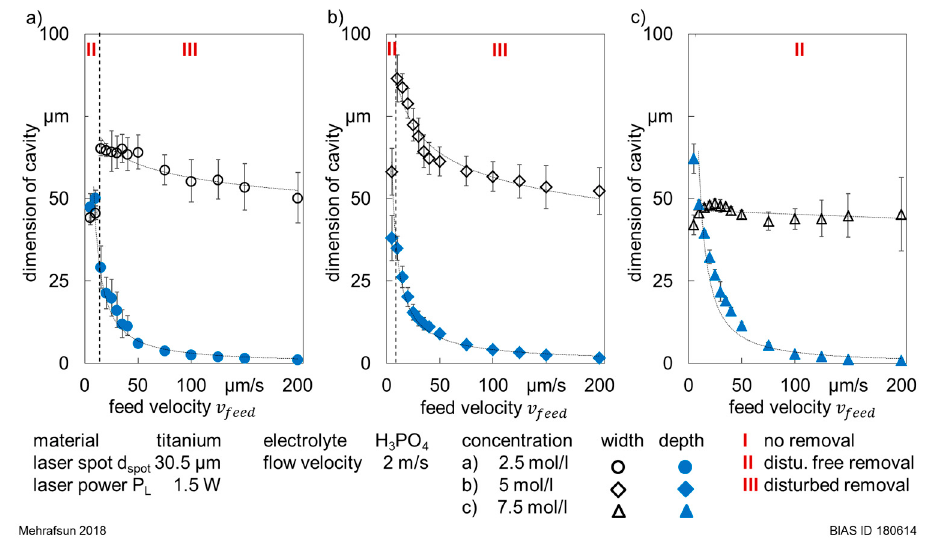
Figure 13. Width and depth of the resulting LCM cavities in titanium at a feed velocity P L of 1.5 W in dependence of the applied laser power obtained at the different H 3 PO 4 solutions with concentrations of ( a ) 2.5 mol/L; ( b ) 5 mol/L and ( c ) 7.5 mol/L.